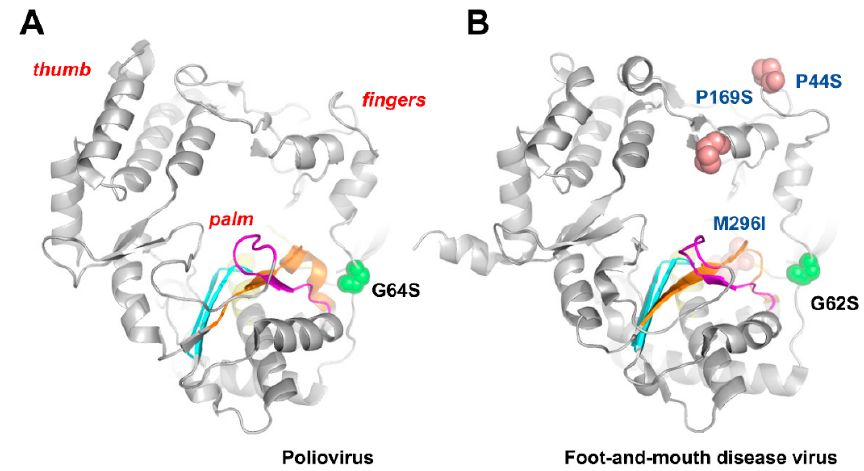
Figure 3. Poliovirus ( A ) and foot-and-mouth disease virus ( B ) RdRp structures showing the location of motifs A–D and residues relevant for ribavirin binding and resistance. Locations of motifs A, B, C, and D are shown in orange, yellow, blue, and magenta, respectively [34,121]. Spheres are used to represent the location of relevant amino acid substitutions. Crystal structures were taken from PDB files 2ILY (poliovirus RdRp) and 1U09 (foot-and-mouth disease virus